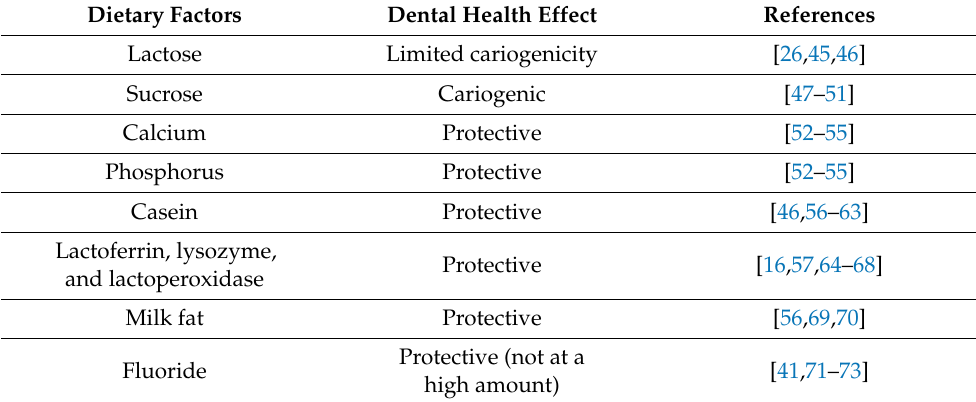
Table 2. The impact of dietary factors on dental